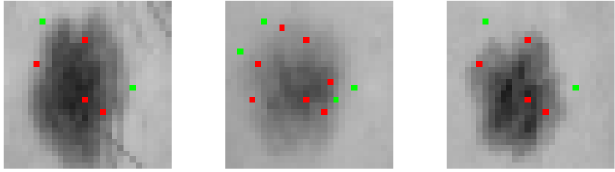
Figure 13. Samples belonging to the “malignant” class, sharing a rule. The first and the second case activate a single rule, while the second is covered by two rules.